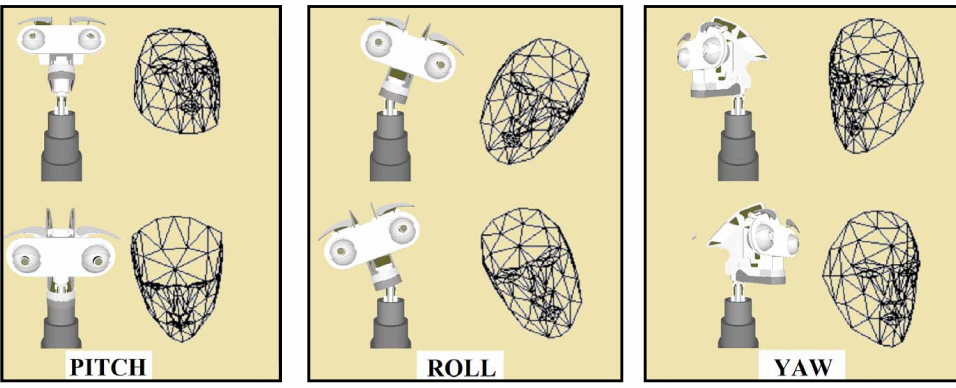
Figure 16. Degrees of freedom of the robotic neck in the imitation